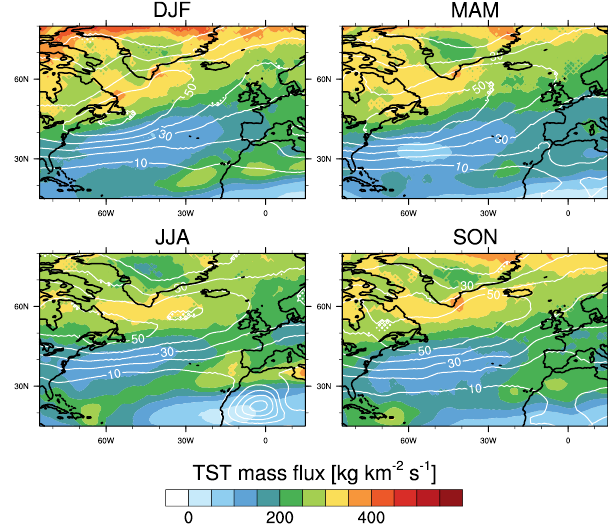
Figure 6. As Fig. 5 but for TST instead of STT.